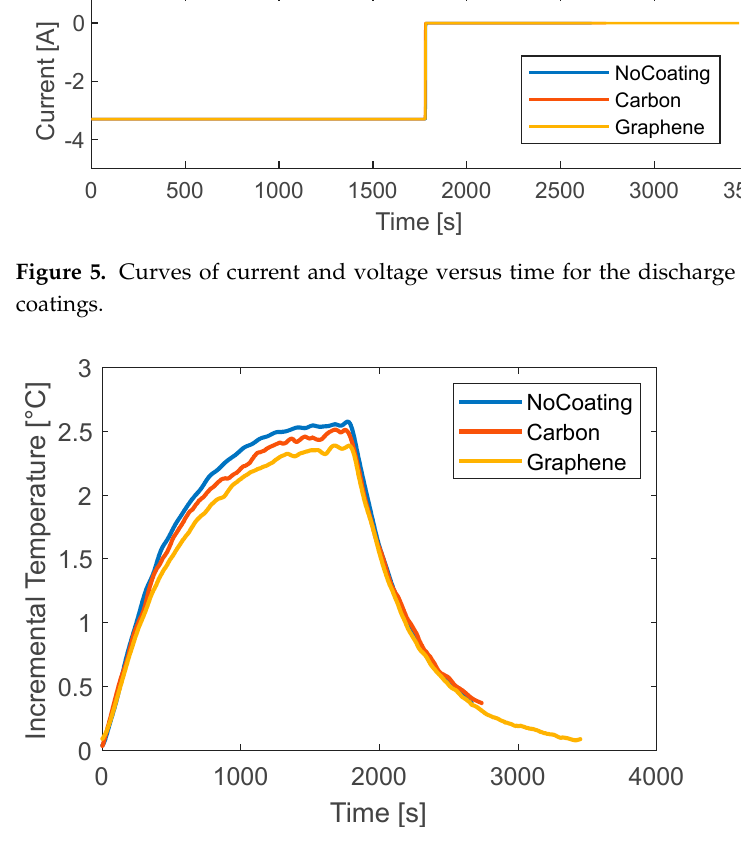
Figure 6. Curves of temperature versus time for different coatings for discharge tests at 1C. Table 3. NRMSE between the curve of temperature for the uncoated and coated battery at discharge rate